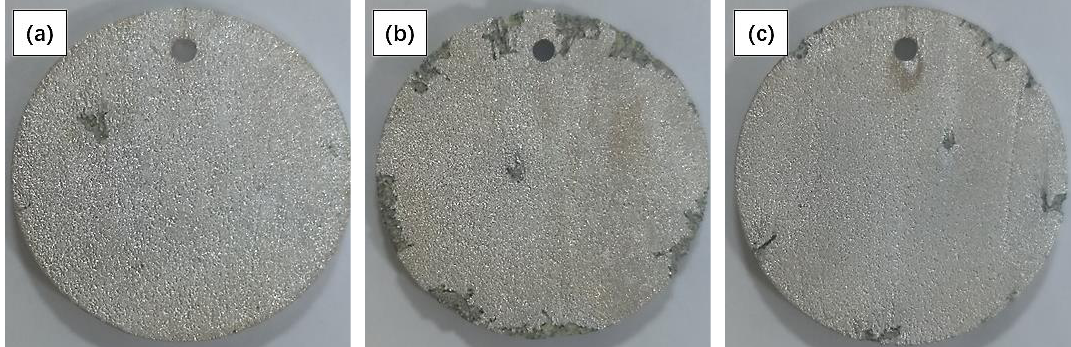
Figure 3. Macroscopic topographies of Mg-Nd alloy after soaking for 7 days in F-state Mg-Nd alloy: ( a ) Mg-1Nd, ( b ) Mg-2Nd, ( c ) Mg-3Nd. The corrosion rates of the three alloys immersed for 7 days were calculated to investi- gate the effect of the Nd element on the corrosion resistance, and the results are shown in Figure 4. Comparing the three kinds of alloys, the average corrosion rate of the Mg-2Nd alloy was the largest, followed by the Mg-3Nd alloy, and the average corrosion rate of the Mg-1Nd alloy was the smallest. The rates were: 0.73 mg · cm − 2 · d − 1 , 1.13 mg · cm − 2 · d − 1 , and 0.81 mg · cm − 2 · d − 1 , respectively. This indicates that with the increase in Nd content, the corrosion rate of the alloy in the SRB medium first increased and then decreased. The immersion experiment showed that the binary alloy with 1% of the Nd element had the best corrosion resistance in the SRB medium, and the worst corrosion resistance was obtained for the alloy with 2% Nd.